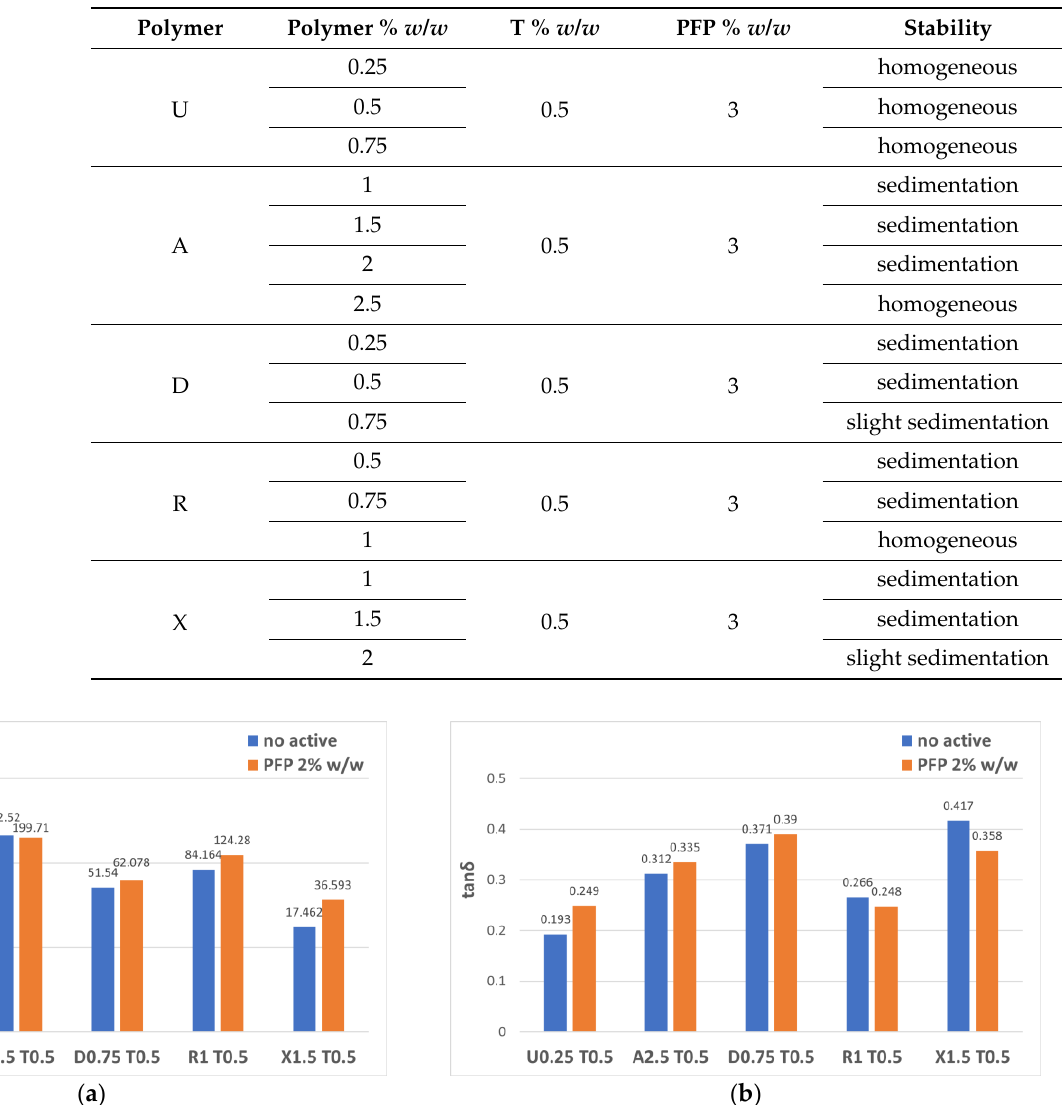
Table 3. Summary of the gel formulations and results of centrifuge stability test.